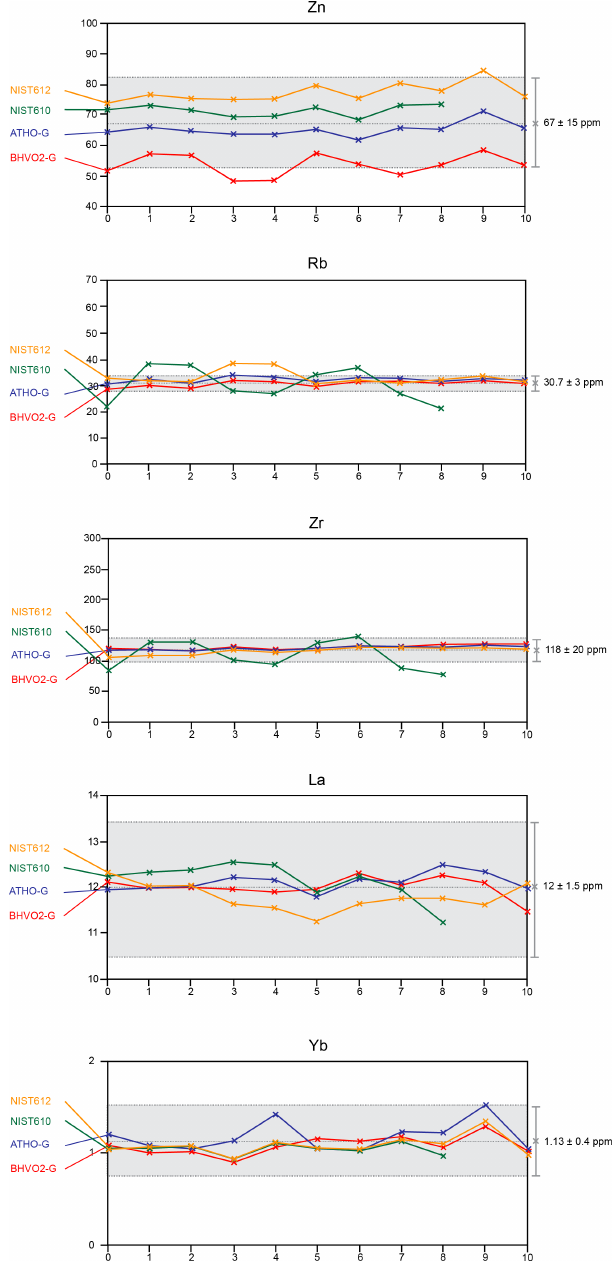
Figure 2. Compilation of trace-element standard data produced during the first run of glass-shard analyses. These data show se- lected element concentrations of secondary standard STHs6/80 nor- malised using difference calibration standards (NIST-612 – orange; NIST-610 – green, ATHO-G – blue, and BHVO2-G – red). The grey shaded area shows the preferred GeoREM reference value (http://georem.mpch-mainz.gwdg.de, last access: June 2021) error margin reported for each element for STHS6/80. Note that for stan- dard NIST610, two data points were removed as outliers; full data can be found in Table